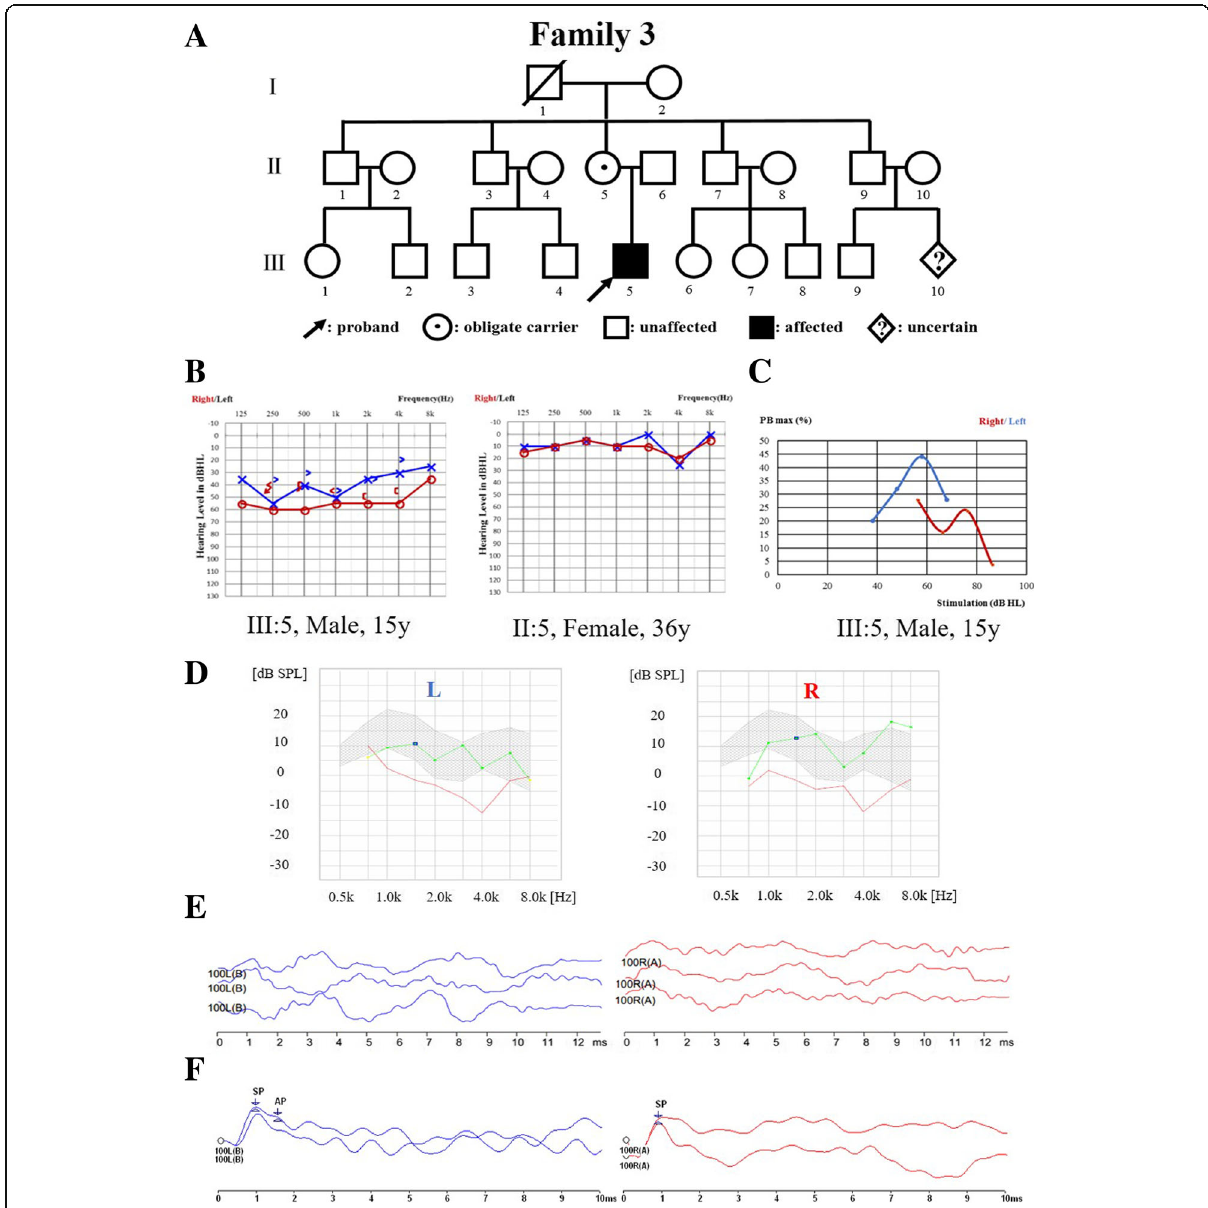
Fig. 3 Pedigree and audiological phenotype of Family 3. a Pedigree of Family 3. The affected subject is coloured black, the proband is indicated by an arrow, unaffected members with black spots indicate obligate carriers of the causative variation, and a rhombus with a question mark is a subject with unknown gender. b Audiograms of the proband (III:5) and his mother (II:5). c Speech recognition score (SRS) of the proband upon different stimulations, showing different tendency from normal controls. d Normal DPOAE result of the proband. e Absence of ABR waves and present CM waves in the proband. f Electrocochleography (ECochG) showed abnormal -SP/AP > 0.4. L, left, blue; R, right,